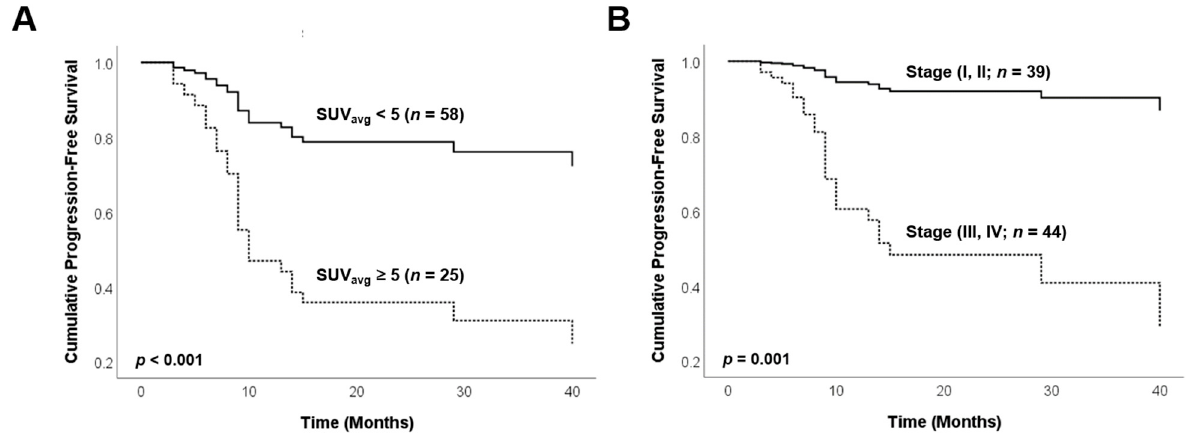
Figure 2. Progression-free survival curves of study subjects sub stratified according to standardized uptake values Average (SUV avg ) ( A ) and Masaoka stage ( B ): SUV avg classified into high/low with 5.0 as a cut-off and Masaoka stage classified into I, II and III, IV.